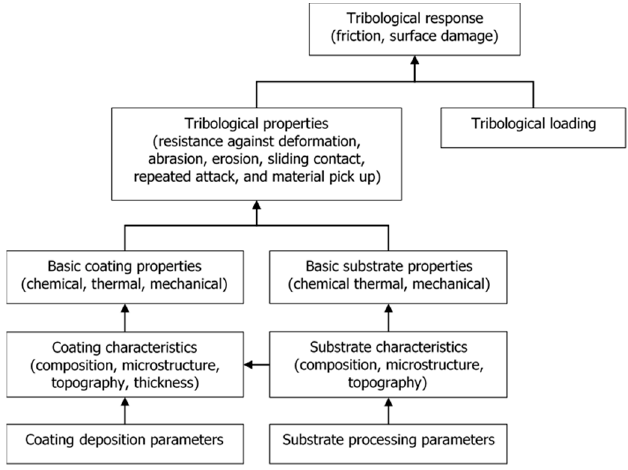
Figure 16. General relation between coating deposition and tribological response [36]. Table 4. Important coating properties and methods used to obtain them [35,36].